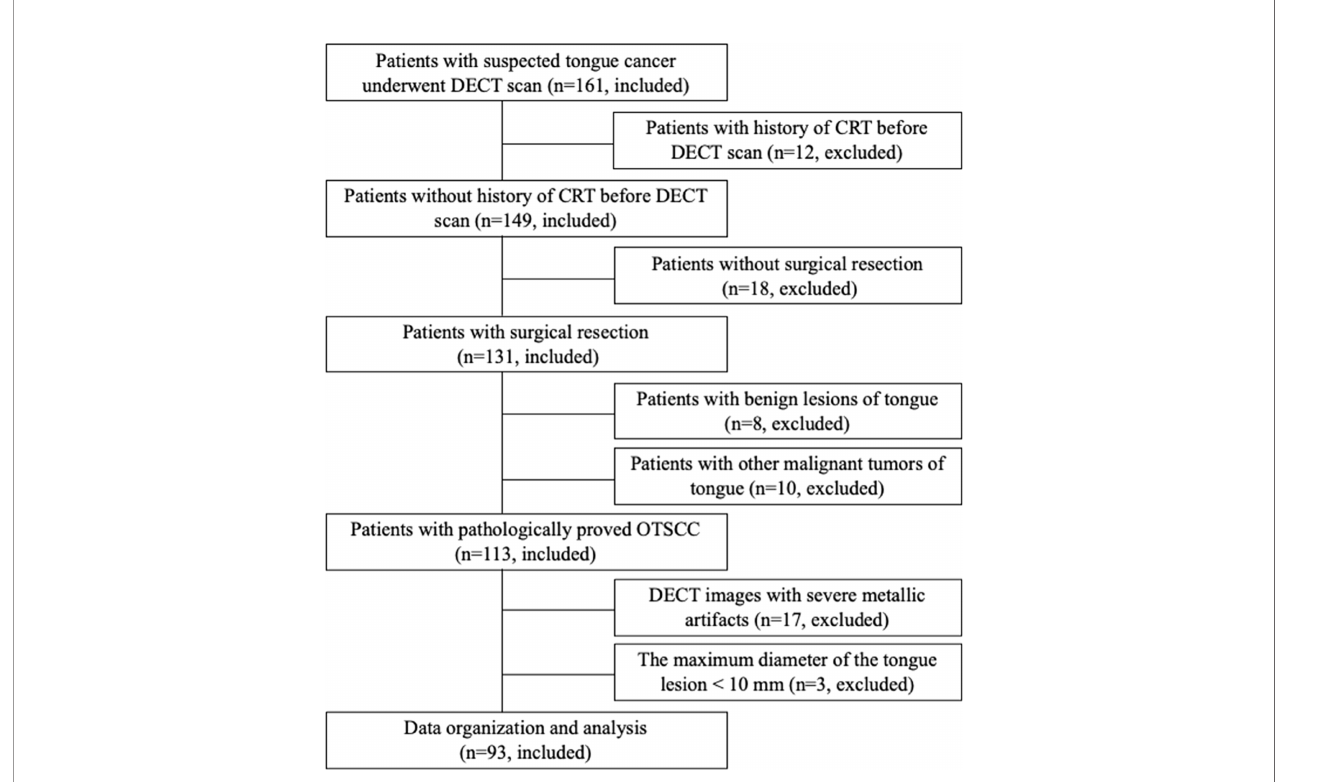
FIGURE 1 | Flowchart shows the strategy for OTSCC analysis and data processing in this